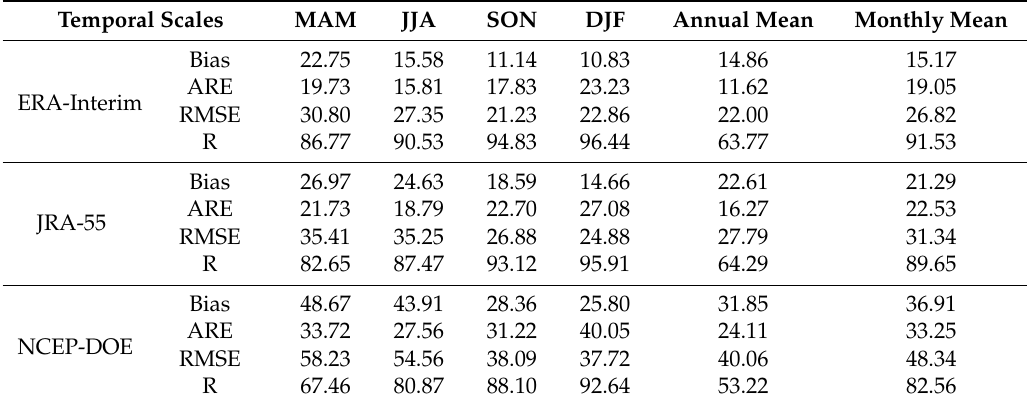
Table 2. Evaluation of three annual, seasonal, and monthly solar radiation reanalysis products at a global scale (unit of Bias and RMSE: W/m 2 , ARE: %) Temporal Scales MAM JJA SON DJF Annual Mean Monthly Mean Bias ERA-Interim